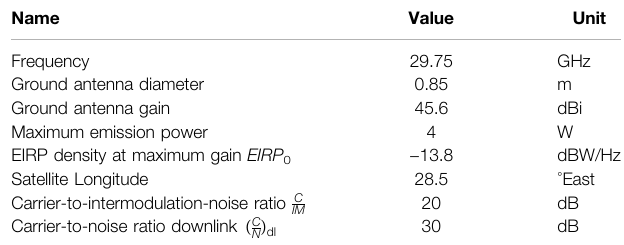
TABLE 1 | Simulation link parameters.